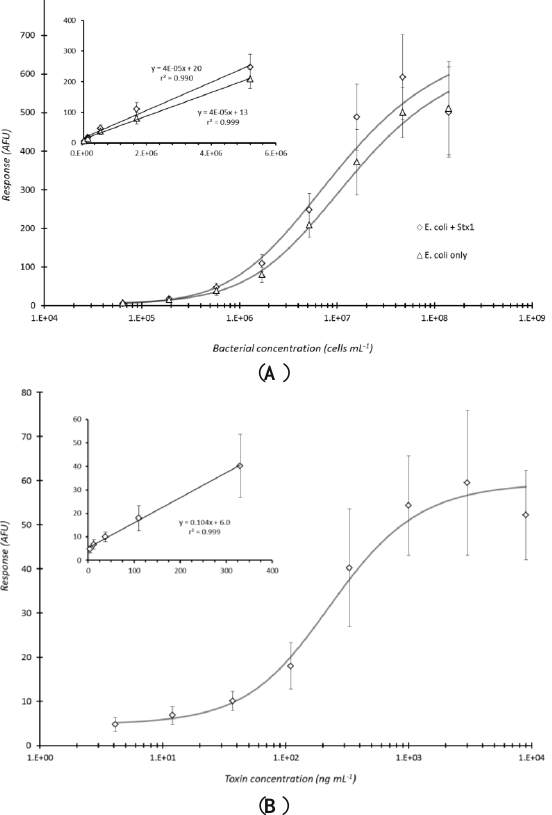
Figure 5. Microarray detection of bacteria and/or toxin under optimized immunoassay conditions. Heat-killed E. coli O157:H7 and Stx1 toxin were combined and 3-fold serially diluted in PBS to yield concentration ranges of 1.4 × 10 8 to 6.4 × 10 4 cells mL −1 and 9 × 10 3 to 4.1 ng mL −1 for the bacteria and toxin, respectively. The samples were subjected to microarray detection using immunoassay conditions (sample centrifuged for 5 min with capture antibody (non-biotinylated for E. coli and biotinylated for toxin, microarray printed to the bottoms of microtiter plate wells) and then reacted with fluorescent antibody conjugate for 60 min before laser-induced fluorescence scanning) optimized in this investigation. The dose-response curves in ( A ) exhibit the microarray response versus concentration for E. coli O157:H7 in the presence or absence of Stx1 whereas ( B ) displays the dose-response curve for Stx1 in the presence of serially diluted E. coli O157:H7. Each data point represented the mean ± standard deviation for 4 of 8 daily technical replicates (with 2 highest and 2 lowest values dropped) from serial dilution series combined with other similarly treated replicates from experiments repeated once.